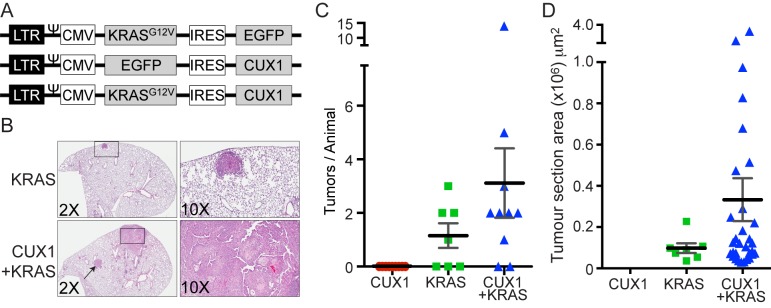
CUX1 and KRASG12V cooperate in lung tumor formation.(A) Schematic representation of the three lentivirus vectors used for tracheal intubation: KRASG12V–IRES-EGFP, EGFP-IRES-CUX1, and KRASG12V-IRES-CUX1. LTR, 5′-long terminal repeat; Ψ, packaging signal; CMV, cytomegalovirus promoter; IRES, internal ribosomal entry site; EGFP, enhanced green fluorescent protein. (B) FVB/NJ mice were infected via tracheal intubation with individual lentiviruses of identical titer expressing CUX1 (n = 9 mice), KRASG12V (n = 7), or CUX1+KRASG12V (n = 10) and lungs were assessed for tumors 18–19 wk later. Tumors were identified following H&E staining of lung sections. Top panels show 2× and 10× magnifications of a grade 1 adenoma caused by KRASV12 expression. Bottom panels show a grade 1 adenoma (arrow) and a grade 2 adenocarcinoma with stromal desmoplasia (box and 10× magnification) caused by CUX1+KRASV12 expression. (C) The graph represents the number of tumors observed per animal. (D) The graph represents the tumor section area calculated as the summed maximal area of all its individual tumors in one or more lung sections for the indicated (number of tumors CUX1 = 0, KRASG12V = 8, KRASG12V+CUX1 = 31). The difference in tumor burden between KRAS and KRAS+CUX is statistically significant by the Mann–Whitney test, p value<0.05.